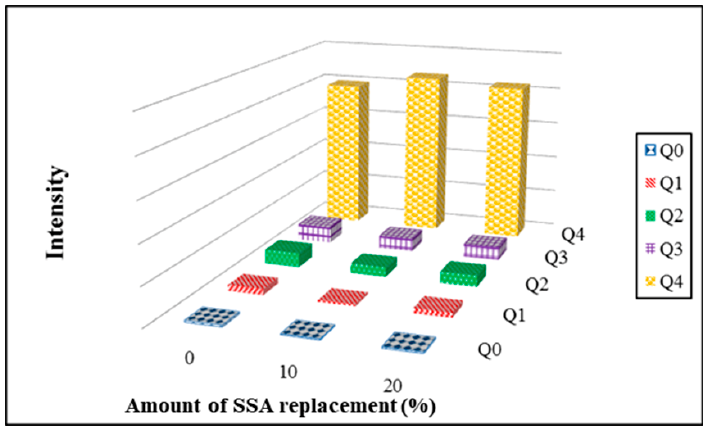
Figure 17. Si ‐ NMR results of various SSA replacement at 1050 °C kiln temperature. Figure 17. Si-NMR results of various SSA replacement at 1050 ◦ C kiln temperature.